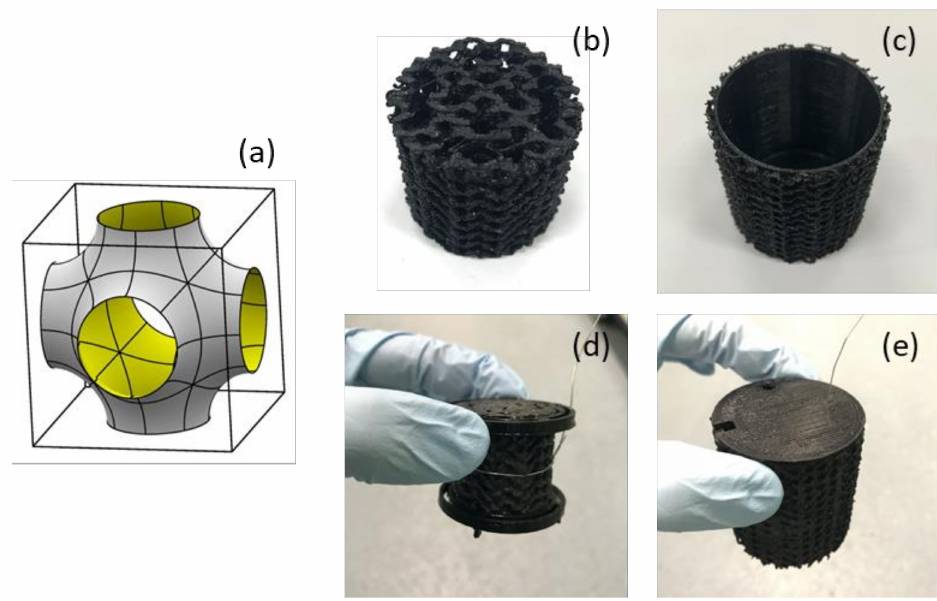
Figure 7. Final design of AM-built MFC: ( a ) Schwarz P surface unit cell design; ( b ) 3D printed anode; ( c ) 3D printed cathode; ( d ) anode with holders; and ( e ) whole